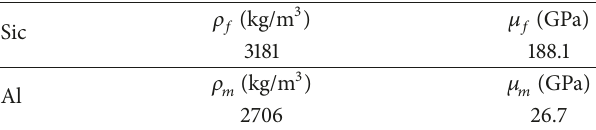
Table 1: Material properties of Sic and